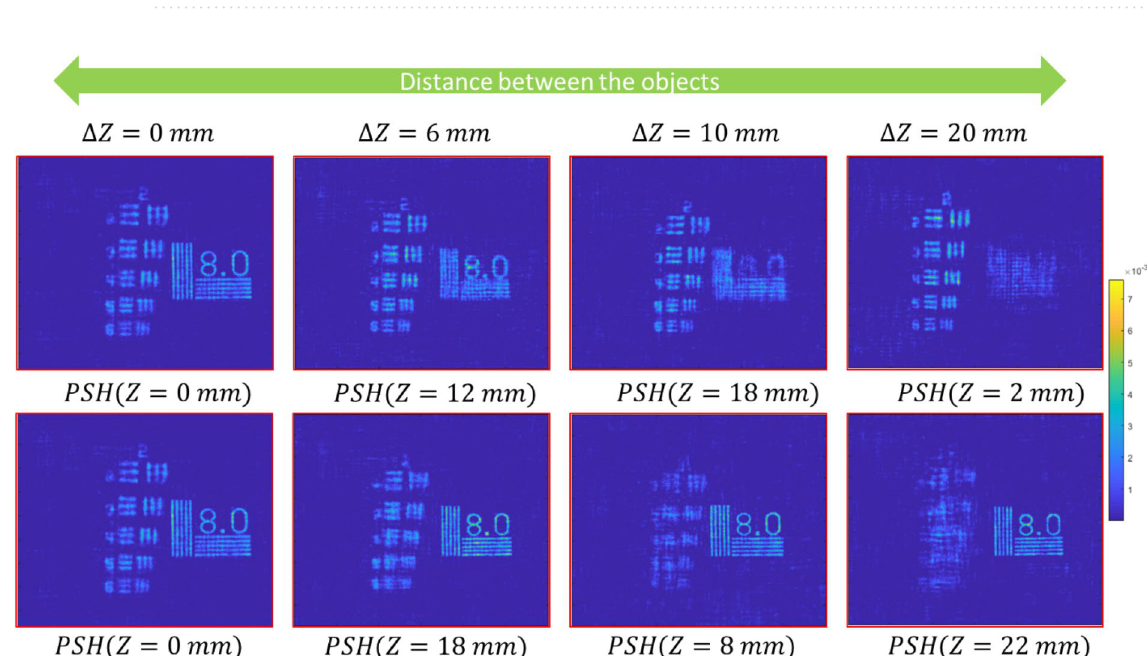
Figure 5. 3D reconstruction results of SCI-COACH system. Two objects are placed in different axial planes with varying separation between two planes for each object